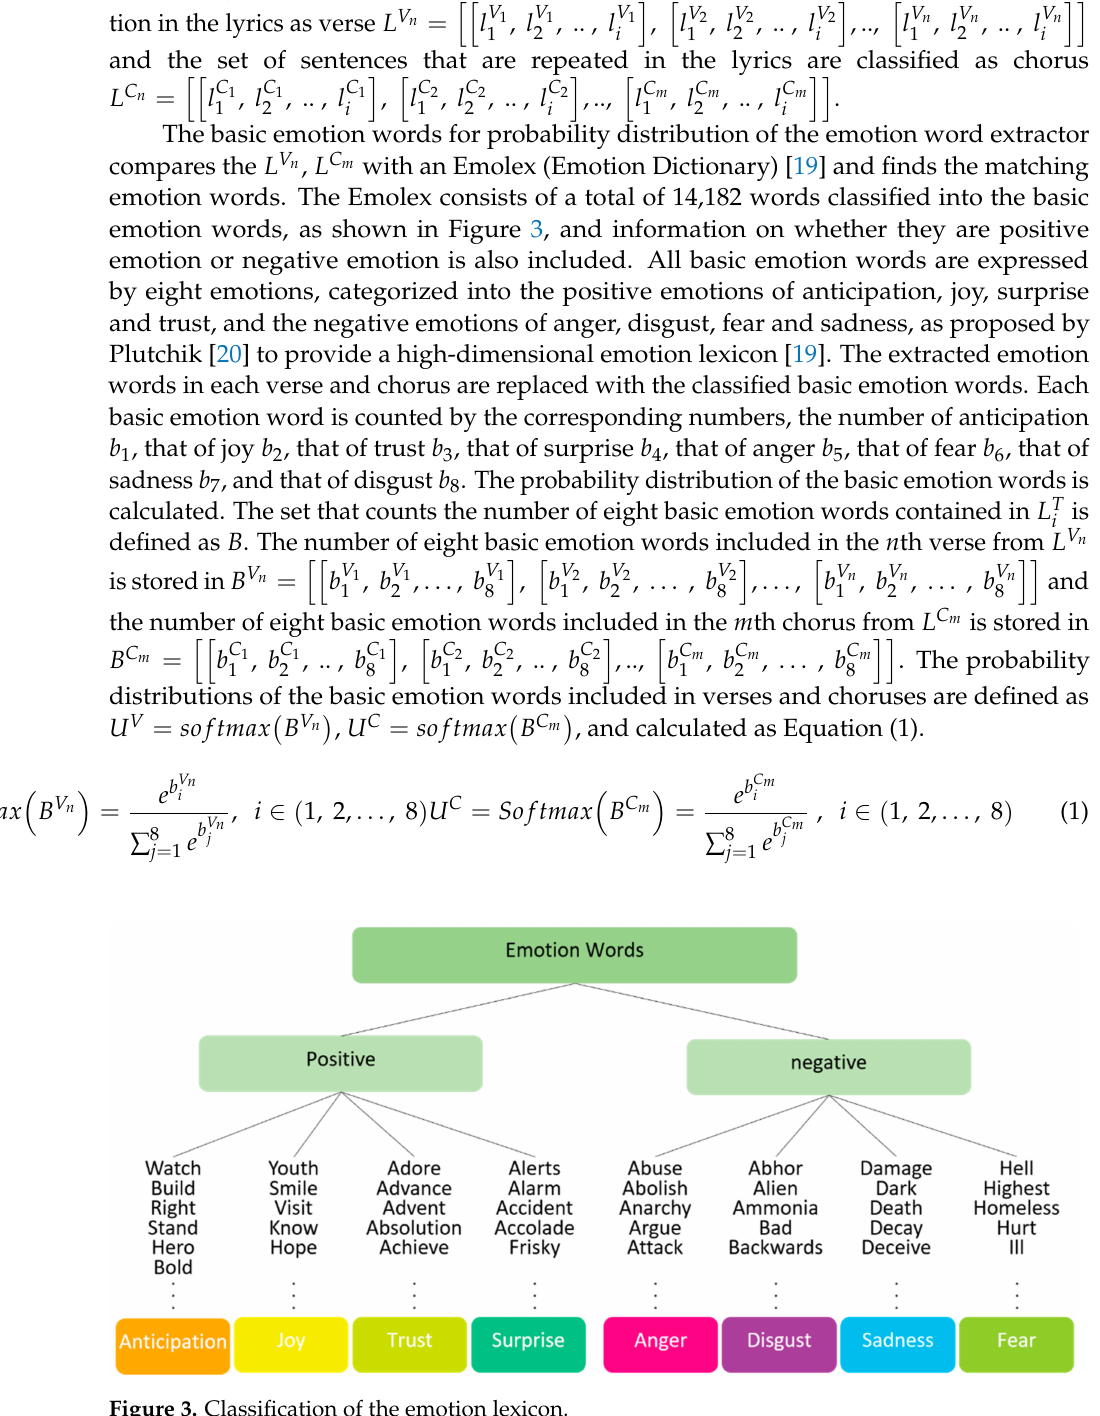
Figure 3. Classification of the emotion